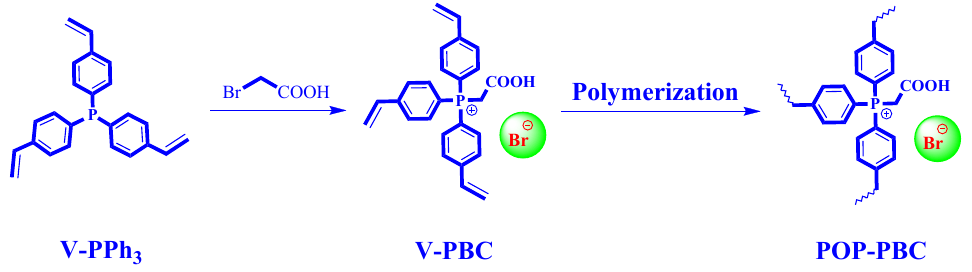
Scheme 1. Illustration of the synthesis process of PIPs from the vinyl-functionalized monomer.